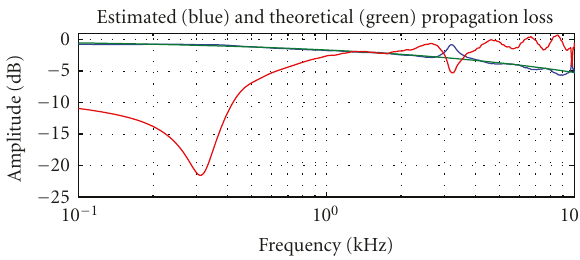
Figure 6: Theoretically modeled propagation loss (green smooth curve) [21] and estimated propagation loss (cid:6) λ ( ω ) (blue) show a close fit, in spite of a far-from-ideal speaker reflection response ρ ( ω ) (red high-pass curve).